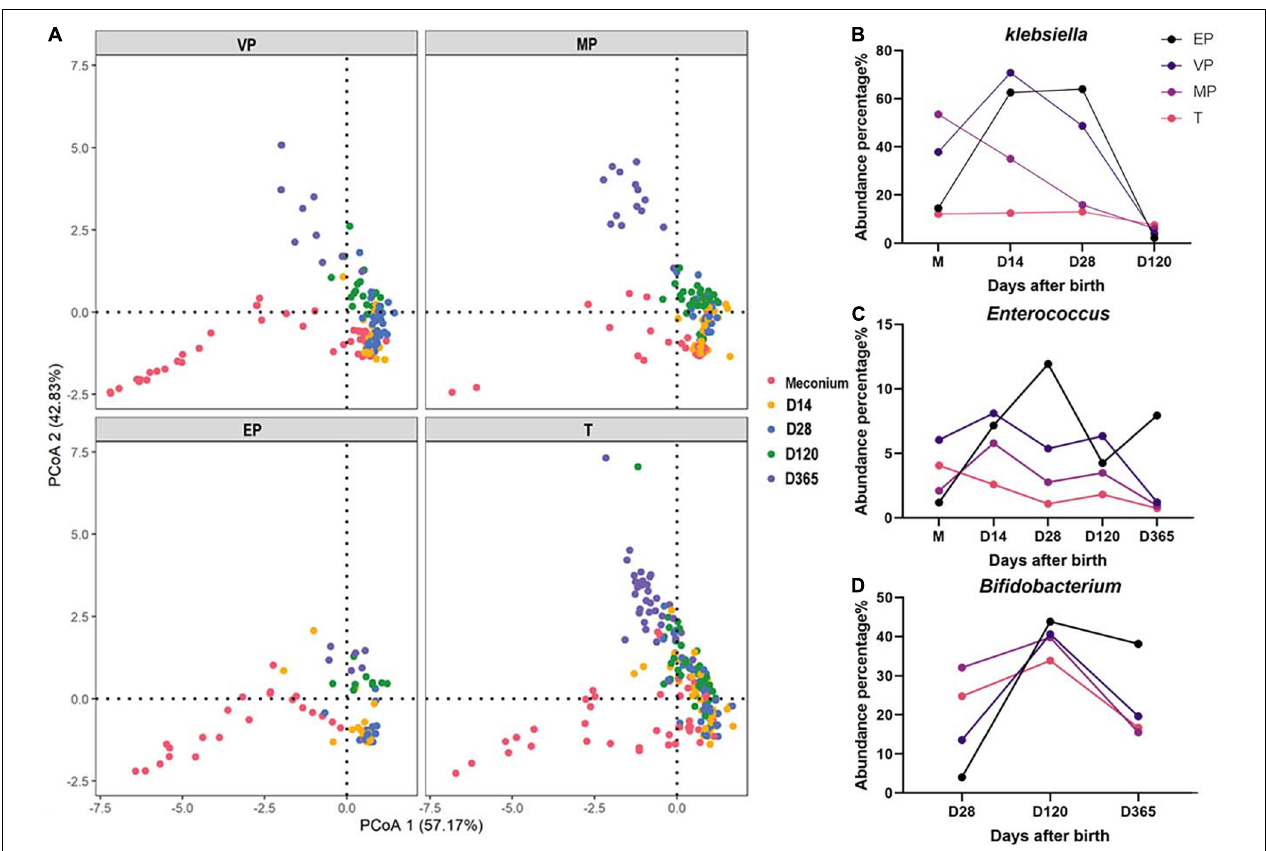
FIGURE 7 | (A) PCoA of all samples in each group. (B–D) The dynamic changes of abundance for Klebsiella , Enterococcus, and